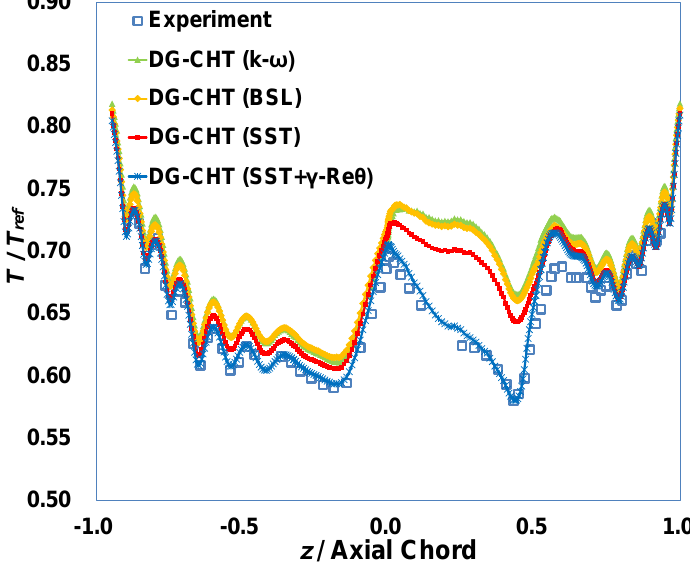
Figure 12. Temperature distributions on the vane surface.